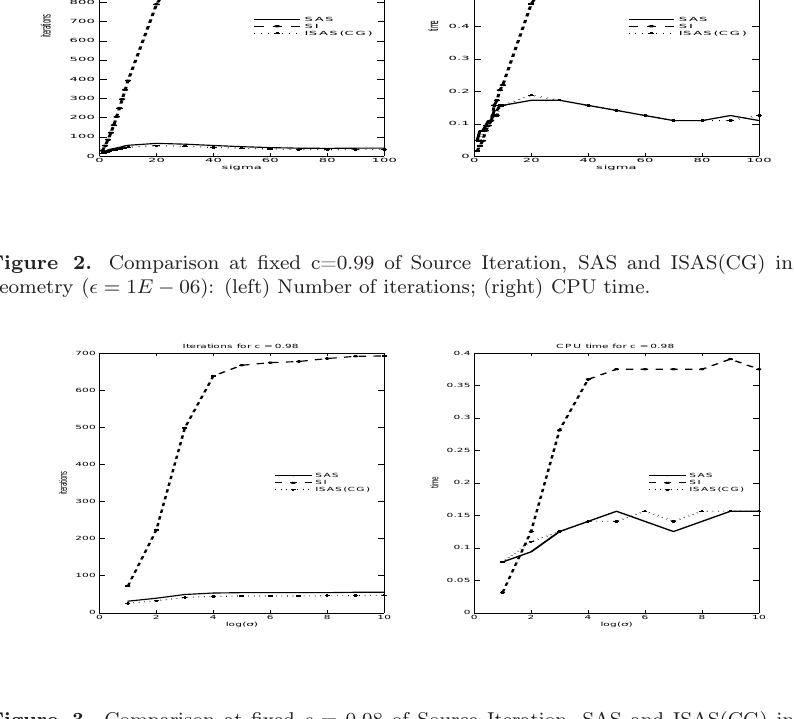
Figure 3. Comparison at fixed c = 0 . 98 of Source Iteration, SAS and ISAS(CG) in slab geometry for large values of σ ( ǫ = 1 E − 06 ): (left) Number of iterations; (right) CPU